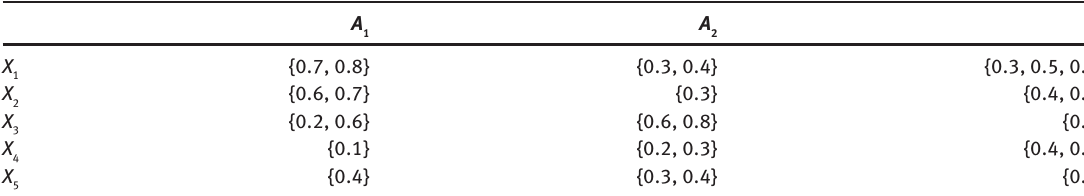
Table 4: Hesitant Fuzzy Decision Matrix.